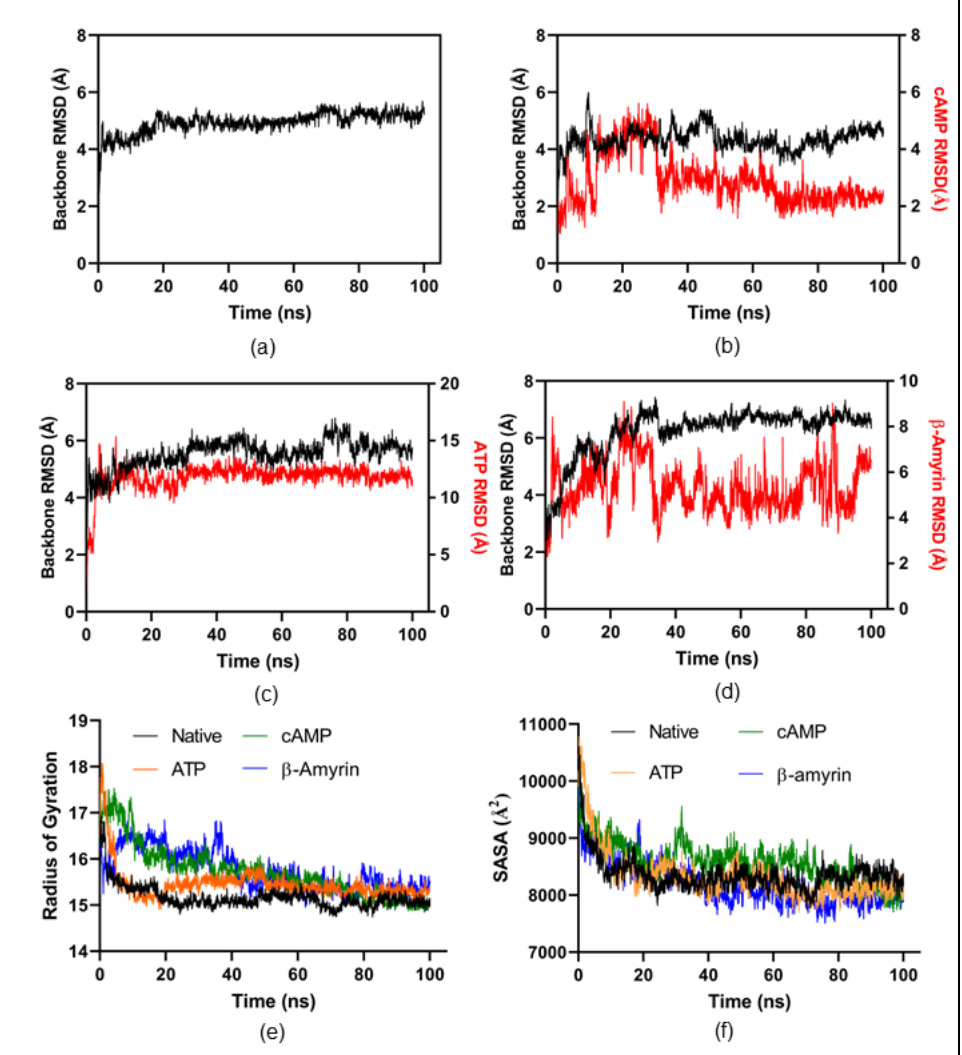
Figure 4. Molecular dynamics simulation of modeled native and ligand docked structure of Rv1636. ( a ) Native-Rv1636 backbone RMSD plotted against the time (ns). RMSD of docked complex ( b ) cAMP, ( c ) ATP, and ( d ) β -Amyrin. ( e ) The compactness of the whole Rv1636 structure is accessed through the radius of gyration. ( f ) Solvent accessible surface area throughout 100 ns MD simulation.